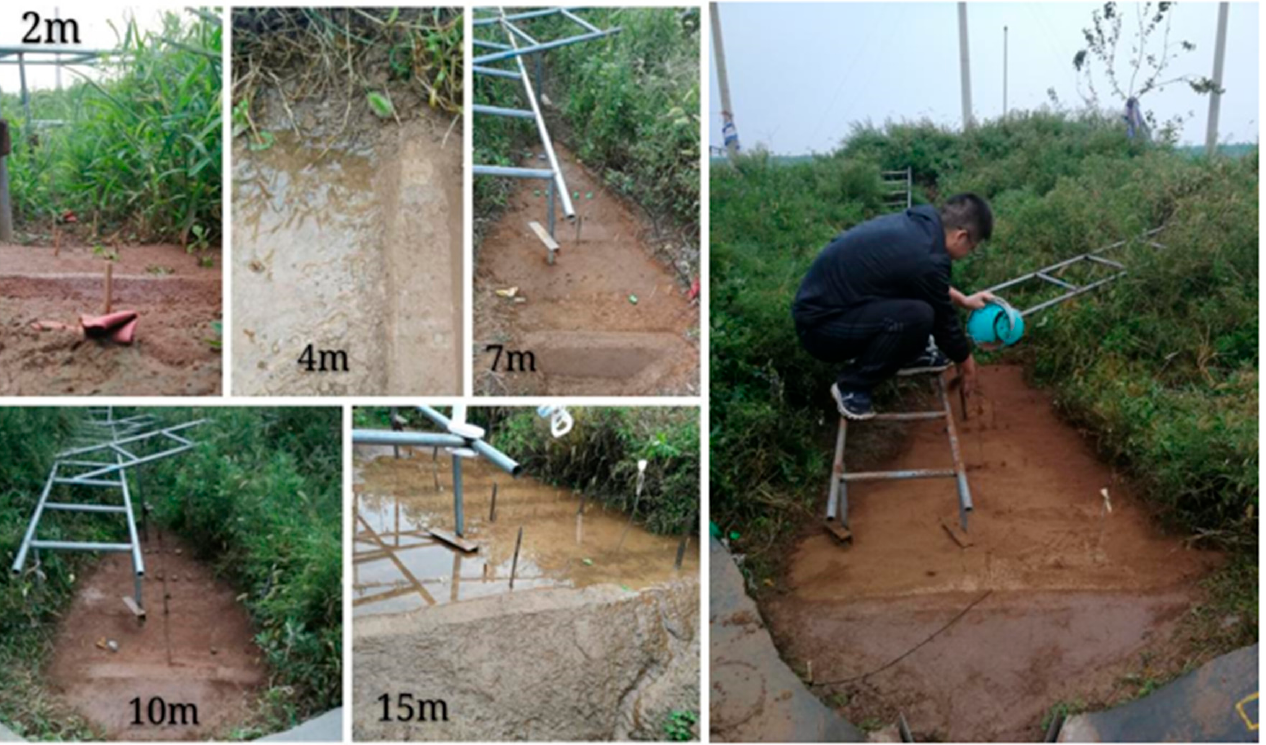
Figure 5. Different scales of land consolidation projects. Table 3. Sectional dimensions of the prototype dam.